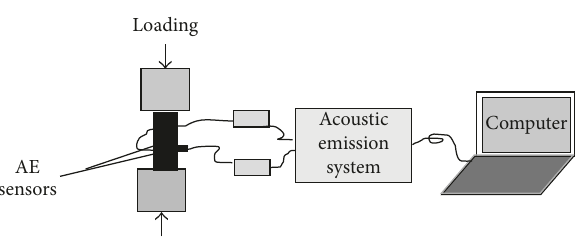
Figure 1: Collected and analyzed system of the acoustic emission.